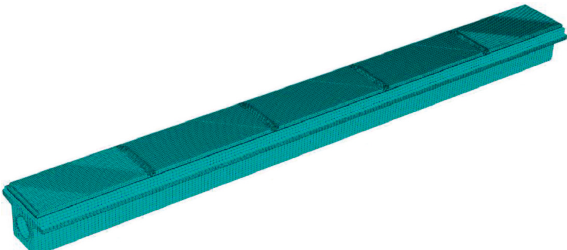
Figure 12: The 3D finite-element